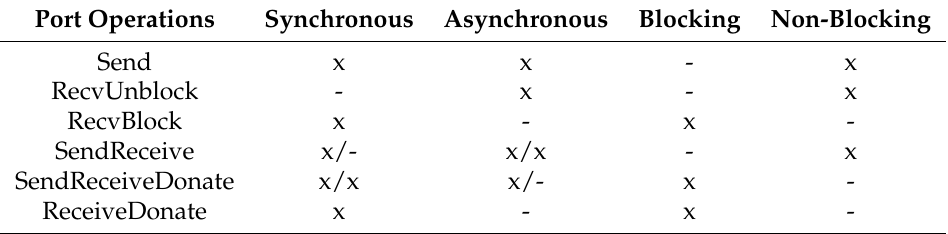
Table 1. Port operations characterization, i.e., if it is synchronous or asynchronous and either blocking or